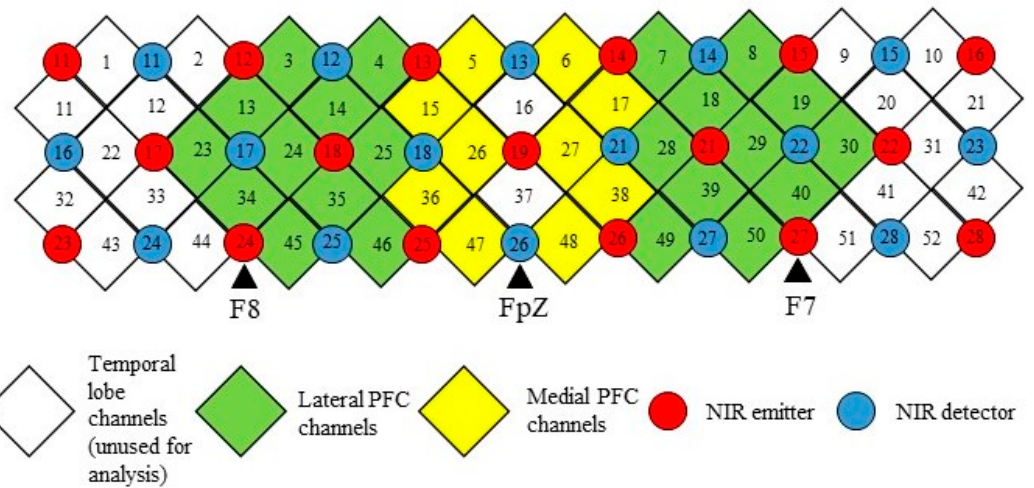
Figure 3. The arrangements of near-infrared channels, emitters, and detectors, as well as the chan- nel groupings. channel